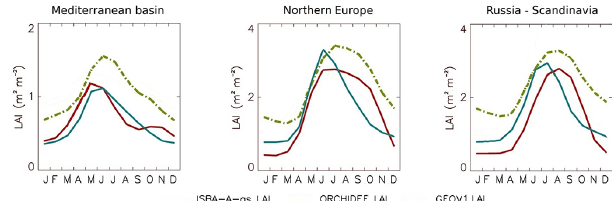
Figure 9. Mean monthly values of the ISBA-A-gs and ORCHIDEE LAI simulations, and GEOV1 LAI observations over the 1991– 2008 period, for the three sub-regions of Fig. 1 (from left to right: Mediterranean Basin, northern Europe, and Russia–Scandinavia).